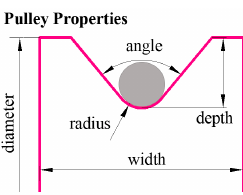
Figure 3. Parameters of the pulley and rope grooves.